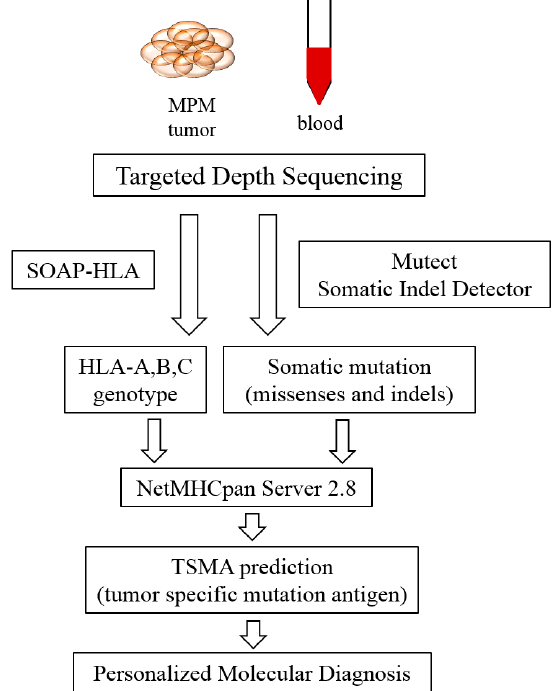
Figure 1. Pipeline for tumor specific neo-antigen analysis: next generation sequencing on data from tumor and blood DNA samples is filtered by Mutect and Somatic Indel Detector software. The HLA genotype is extracted from next-generation sequencing (NGS) data by SOAP-HLA. NetMHCpan server 2.8 is a common tool for the prediction of the binding ability of mutant peptides-HLA.